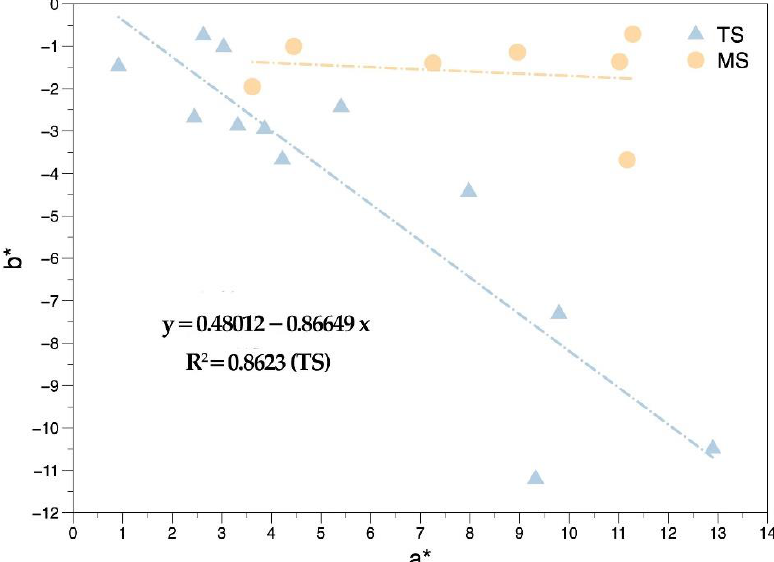
Figure 13. The color coordinate a* is inversely proportional to b* for TS samples, while a* barely depends on b* for MS samples.